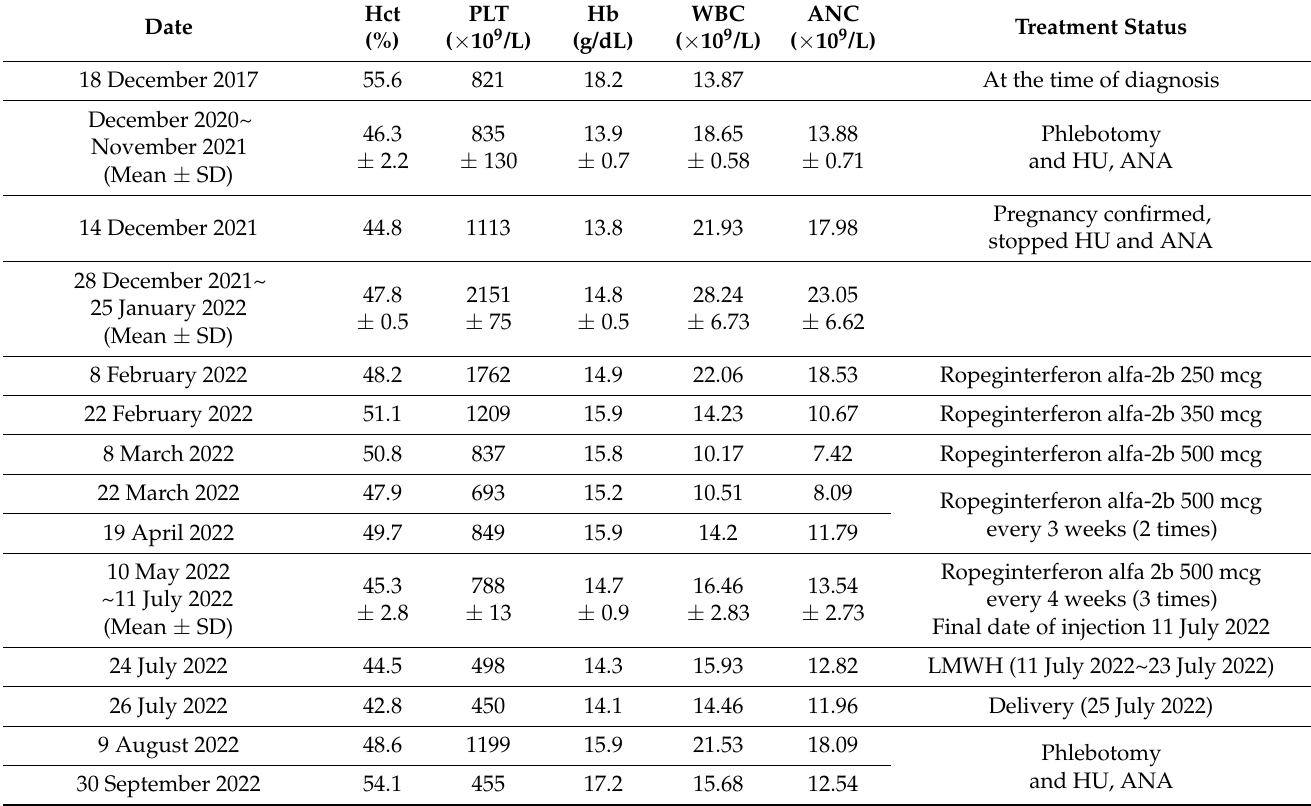
Figure 2. Dynamics of PLT count during pregnancy. Total of 8 doses of Ropeginterferon alfa-2b from 8 February 2022 to 11 July 2022. Injection schedule and dose: A. Every 2 weeks (250-350-500 mcg), b. Every 3 weeks (500 mcg), and c. Every 4 weeks (500 mcg). Table 1. Laboratory results and details of treatment status during